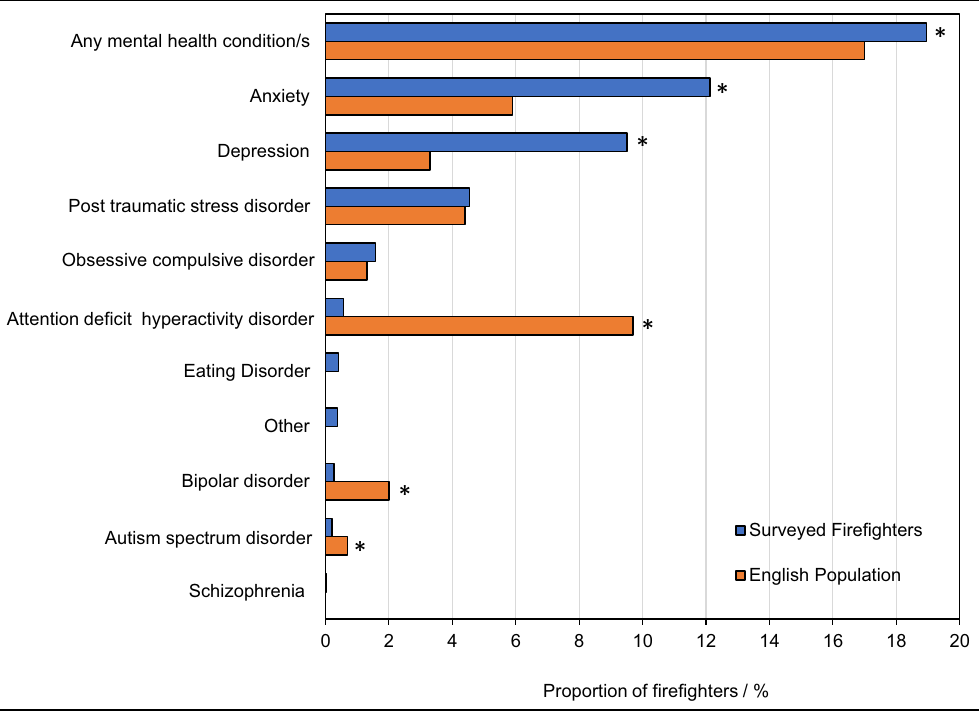
Figure 1. Firefighters’ Mental Health Conditions. The proportion of total surveyed firefighters with any, or specific, mental health disorders (blue). The prevalence of mental health disorders in the general English population 39 is displayed for comparison (orange). “Any mental health condition”, “anxiety” and “depression” among surveyed firefighters is compared to “any common mental disorder”, “generalised anxiety disorder” and “depressive episode” in the general English population, respectively. * indicates a p -value of < 0.05 for differences in proportions between firefighters and English